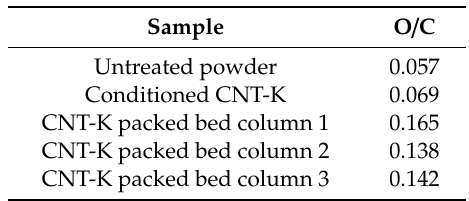
Table 1. Determination of surface oxygen content using X-ray photoelectron spectroscopy for untreated (as provided by the producer), conditioned (acidic treatment, washed, stored as DI-water slurry and dried) and used CNT-K (applied in di ff erent packed beds). The spectra and further information are found in Figures S7 and S8. The material was washed several times with DI-water to avoid adsorbate